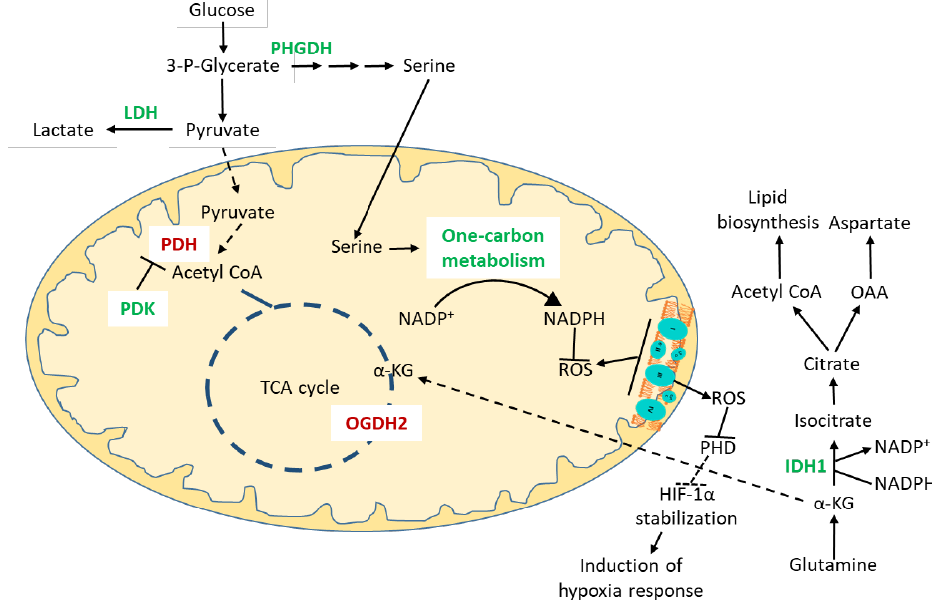
Figure 2. Metabolic reprogramming supporting the redox balance in mitochondria during hypoxia. ROS (reactive oxygen species) generated by the electron transport chain in the mitochondrial matrix during hypoxia. The Rieske iron–sulfur protein (RISP) of complex III generates ROS in the cytosol, which inhibits prolyl hydroxylase (PHD), resulting in HIF-1 α (hypoxia inducible factor-1 α ) stabilization followed by the induction of various hypoxia responses. Seine catabolized in the mitochondria in one-carbon metabolism to generate NADPH to mitigate ROS in the mitochondria in Myc transformed cancer cells. Cytosolic serine biosynthesis is upregulated via the upregulation of phosphoglycerate dehydrogenase (PHGDH) to support mitochondrial serine catabolism. Glucose carbon is diverted to lactate production, decreasing entry into the mitochondria and reducing the TCA cycle flux. The induction of a hypoxia response causes the inhibition of oxoglutarate dehydrogenase (OGDH2), rendering α -ketoglutarate ( α -KG) to be carboxylated by isocitrate dehydrogenase 1 (IDH1) in the cytosol, contributing to reductive carboxylation supporting the lipid and nucleotide biosynthesis (via aspartate) in hypoxia. Dashed lines represent downregulation. Green and red represent up and downregulated enzymes and pathways as part of the hypoxia response. OAA, oxaloacetate; 3-P-Glycerate, 3-phosphoglycerate.